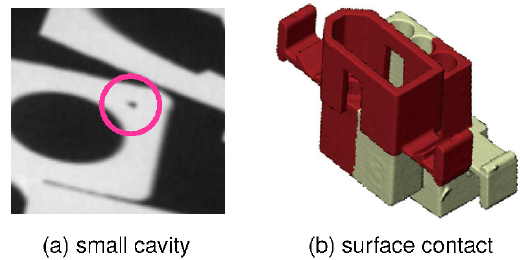
Fig. 9 Limitations of the current graph-based template matching. When (a) small cavities are included in a part and (b) two parts are in contact with a face, the distance field of the part will be inconsistent with that of the template. The inconsistency propagates to the graph structure; thus, our system cannot match the parts appropriately.